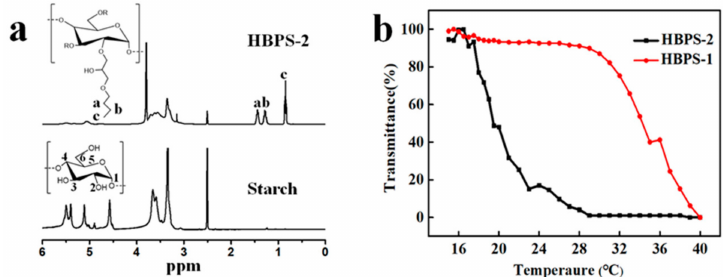
Figure 1. ( a ) 1 H NMR spectra of soluble starch and HBPS-2; ( b ) Changes of transmittance at 550 nm vs. temperature for HBPS-1 (5 g / L, DS BGE = 0.31) and HBPS-2 (5 g / L, DS BGE = 0.42) recorded to determine the LCST value through heating process.